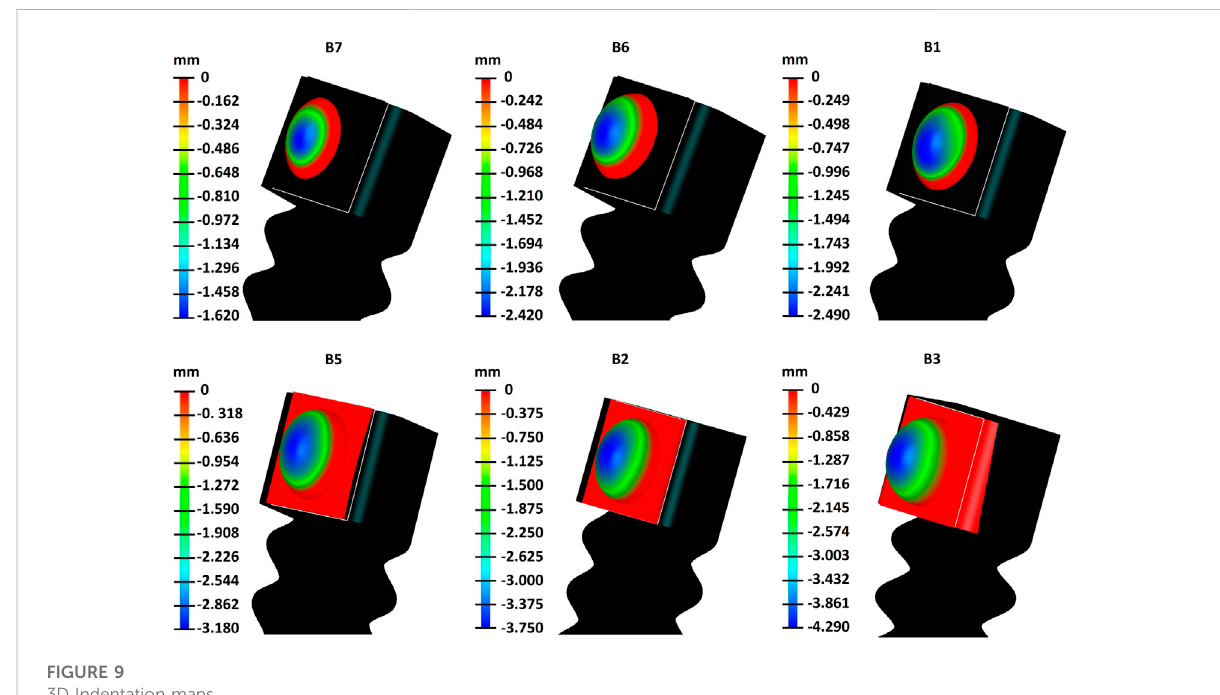
FIGURE 9 3D Indentation